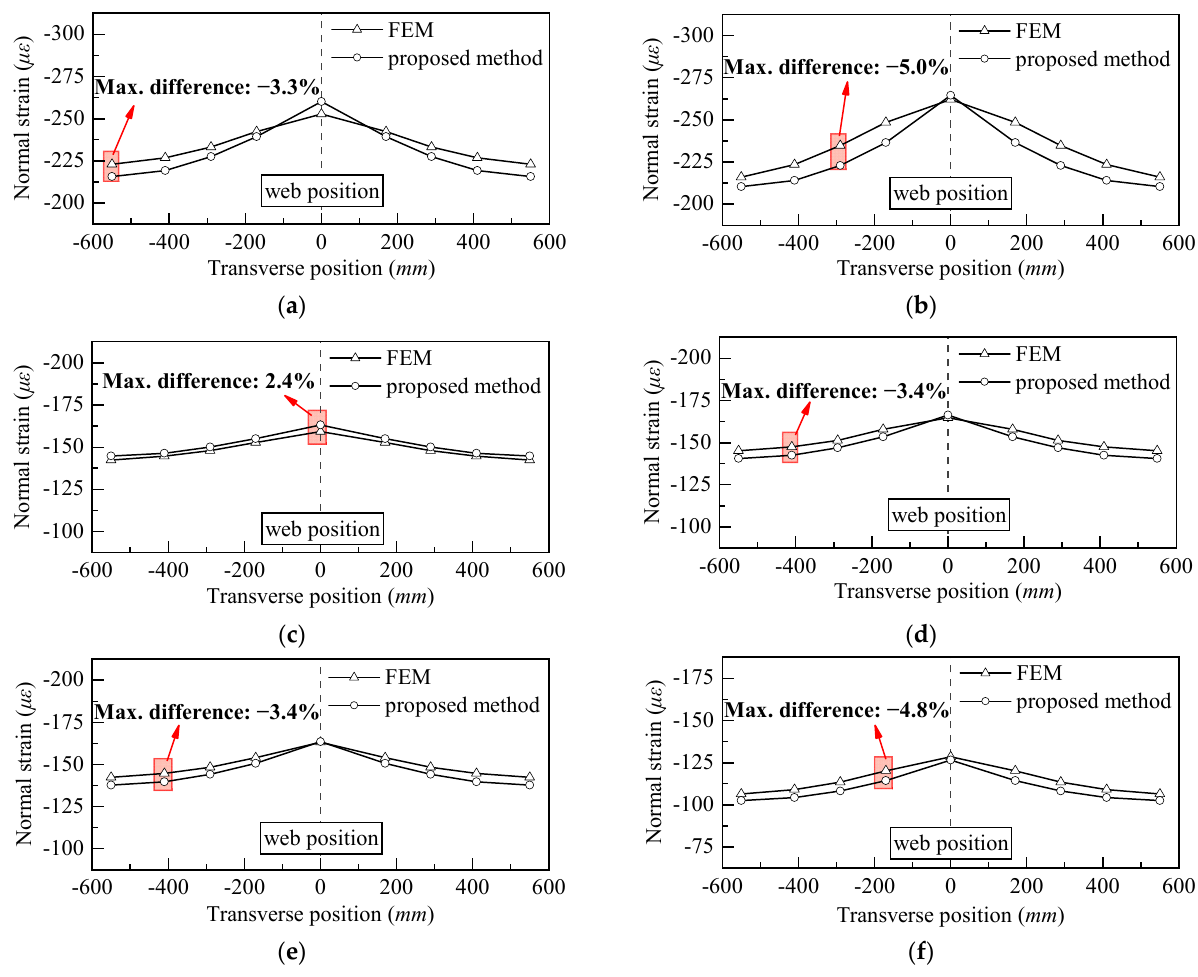
Figure 11. Loading conditions (unit: mm): ( a ) LC1; ( b ) LC2.